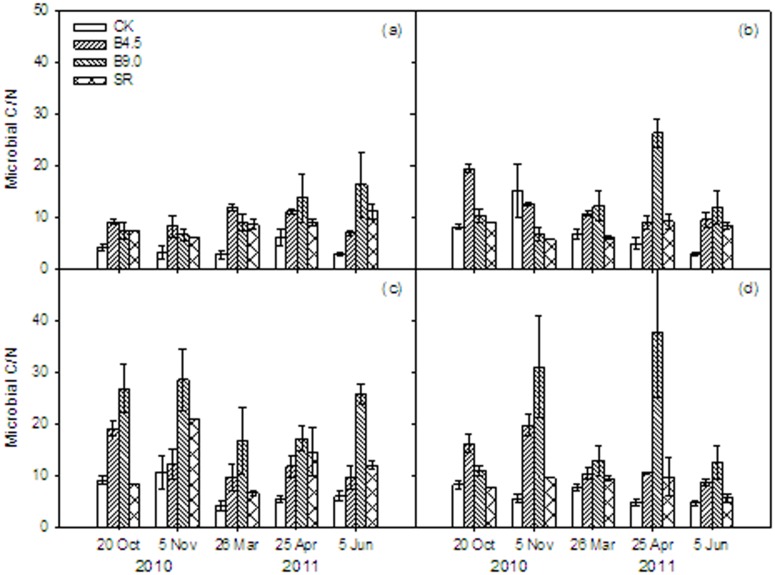
The ratio of soil microbial biomass carbon (MBC) to soil microbial biomass nitrogen (MBC/MBN) under different treatments (CK: control, B4.5: 4.5 t ha−1 yr−1 biochar addition, B9.0: 9.0 t ha−1 yr−1 biochar addition, SR: incorporation of wheat straw) and different soil depths (a: 0–5, b: 5–10, c: 10–20, and d: 20–30 cm) during winter wheat season.Vertical bars represent the standard errors for means of each treatment (n = 3).